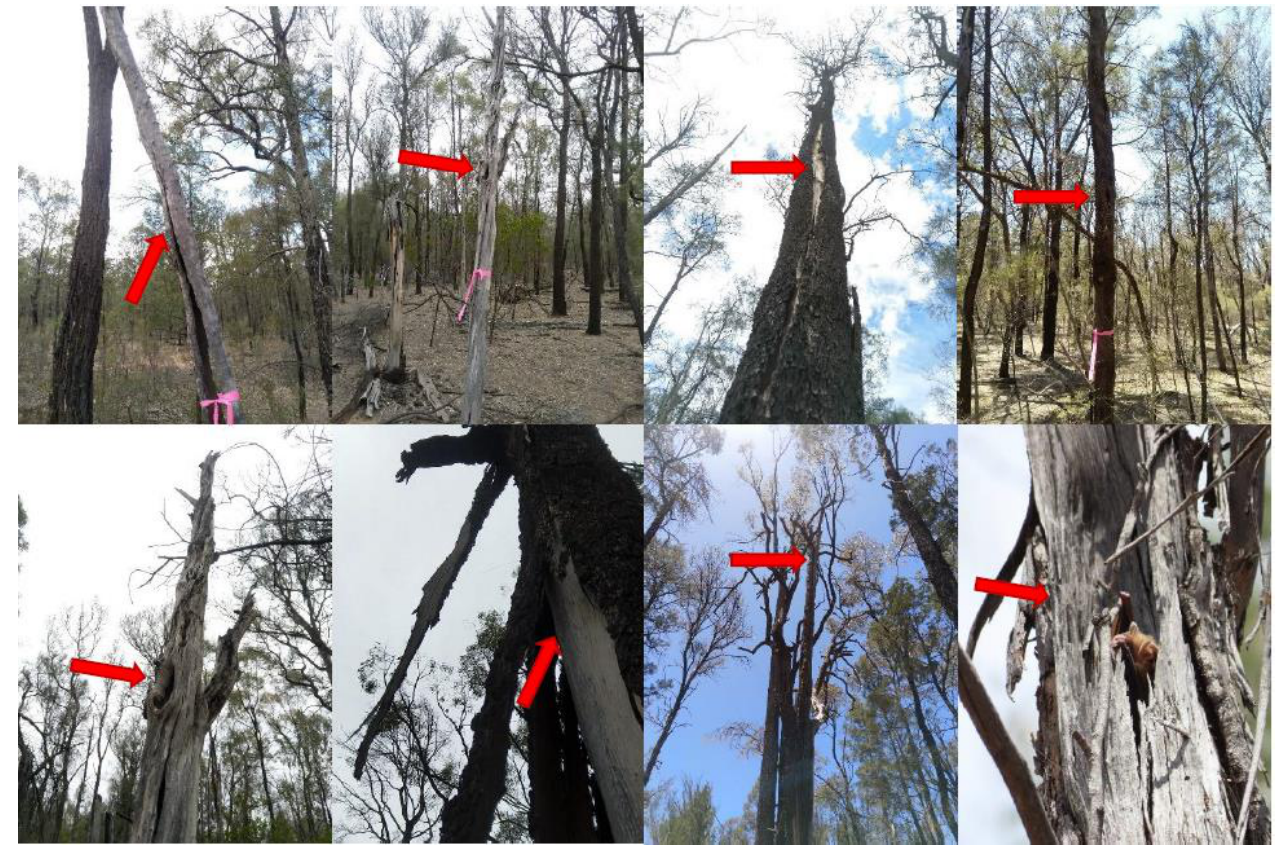
Figure 6. Images of a selection of roost trees used by N . corbeni . Red arrow indicates location of bat.